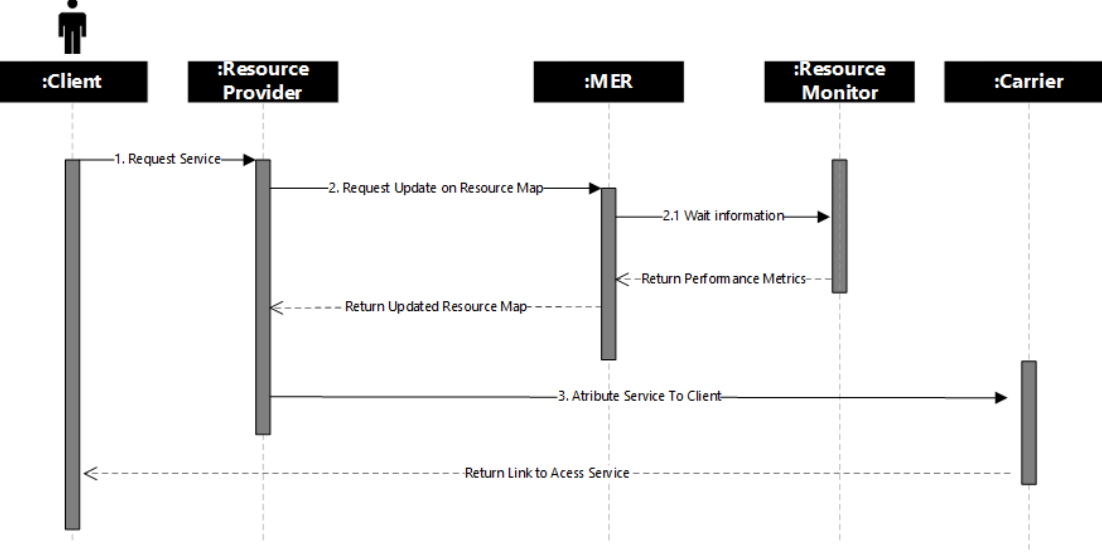
Figure 4. Sequence diagram of